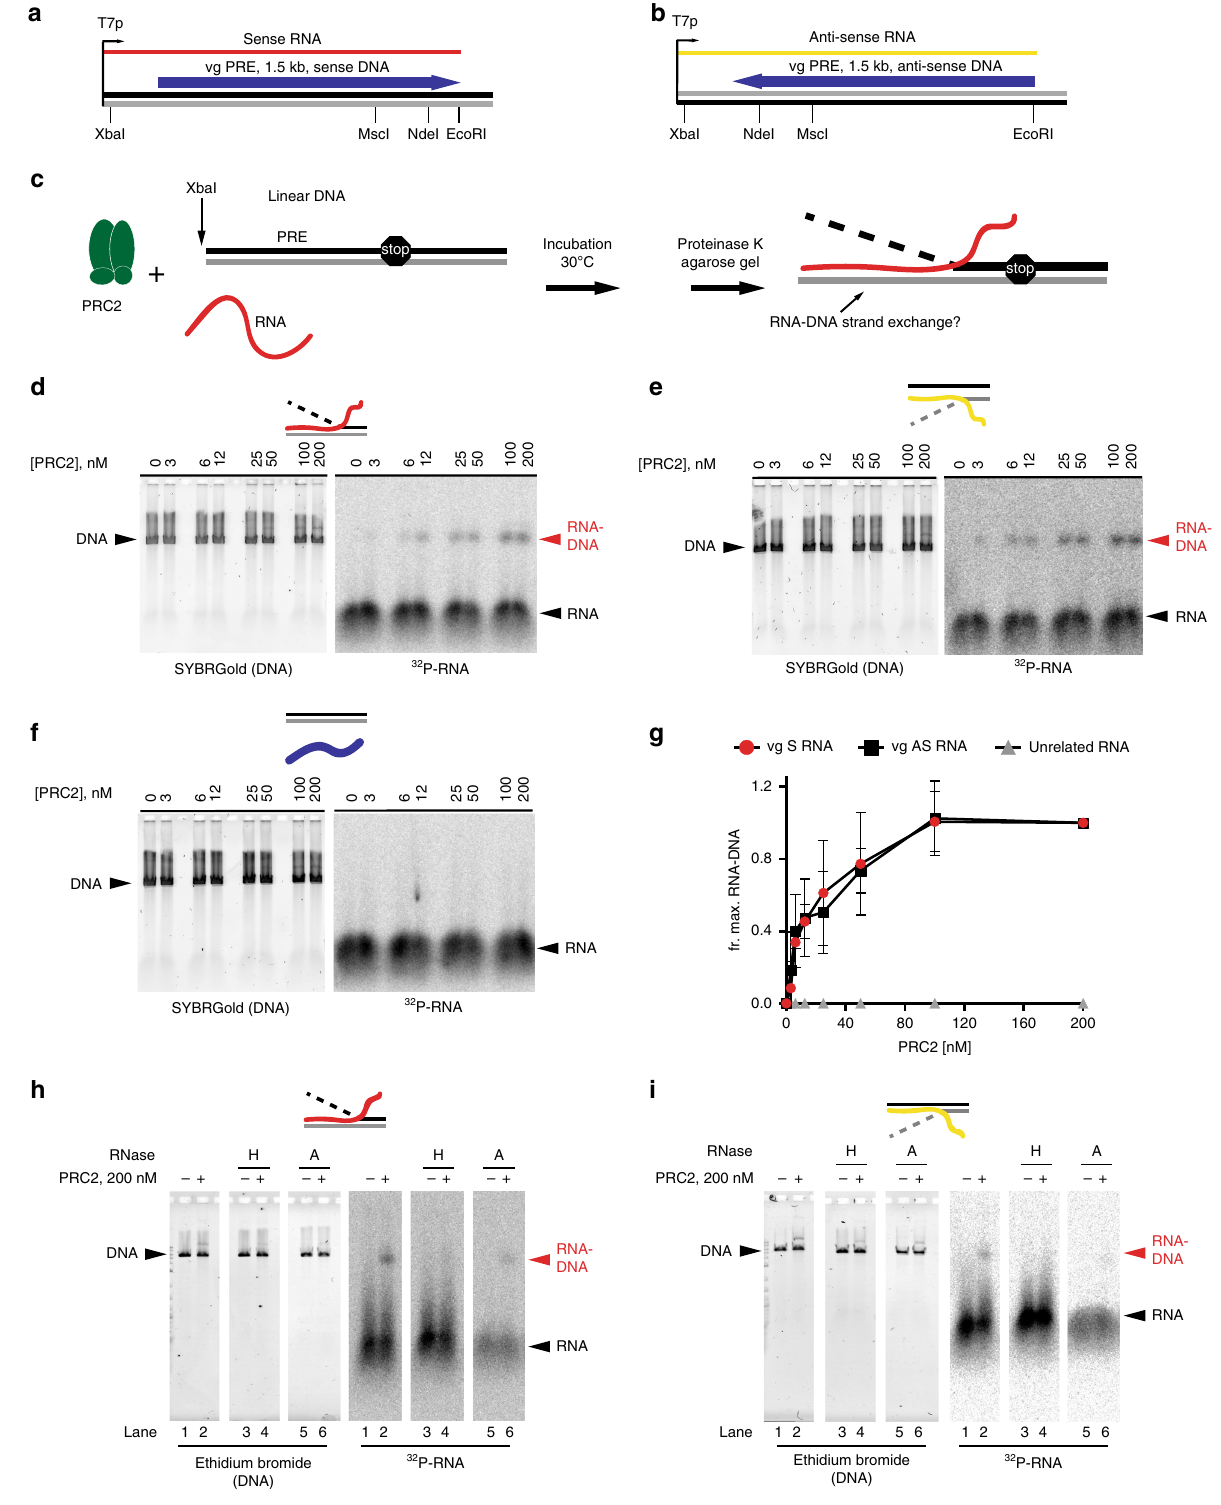
Fig. 3 PRC2 has RNA – DNA strand exchange activity. a , b Nucleic acids used for RNA strand exchange. Plasmids with the vestigial ( vg ) PRE in either orientation are transcribed to produce sense ( a ) or anti-sense RNAs ( b ). Linearized plasmid is used as the DNA template. “ Stop ” indicates where the RNA ends relative to the DNA. c Strand exchange assay scheme. d – f Titration of PRC2 with either the sense ( d ) or anti-sense ( e ) vg PRE RNA, or a non- complementary RNA ( f ). g Quanti fi cation of three titrations; graphs show mean + / − S.D. of the the fraction of signal with 200 nM PRC2. h , i RNA strand invasion products are sensitive to RNaseH (lane 4) but resistant to RNaseA (lane 6). See also Supplementary Fig. 6. Source data are provided in Source Data fi